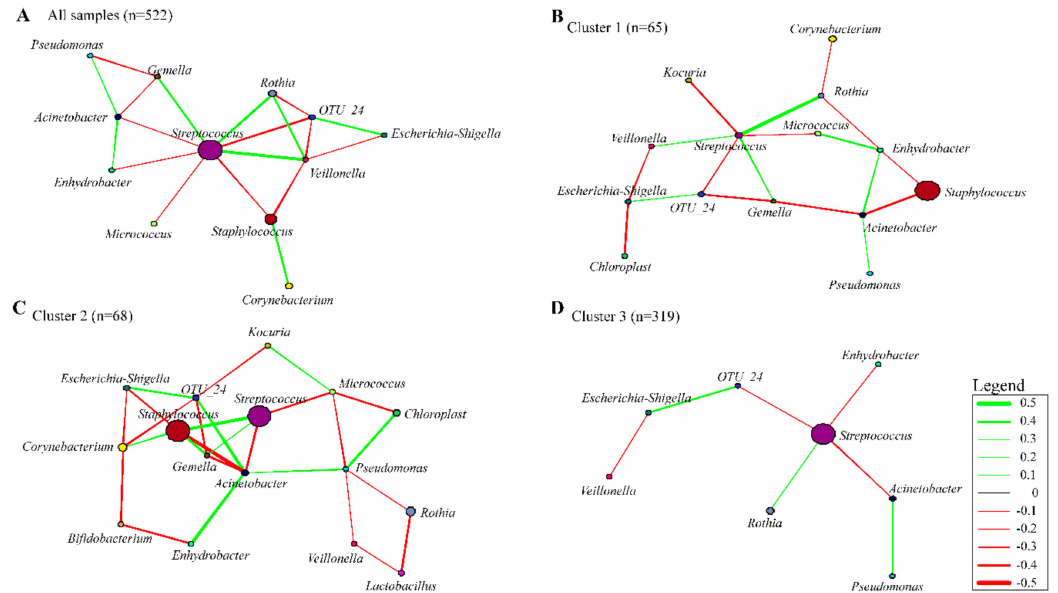
Figure 7. Bacterial networks within the human breast milk bacteriome community based on correlation between relative abundances. Figures show correlations between predominant bacteria in ( A ) all HBM samples, ( B ) cluster 1, ( C ) cluster 2, and ( D ) cluster 3. Nodes and node sizes represent bacterial genera and their relative abundances, respectively. Green and red lines represent positive and negative correlations respectively between the bacteria, with the thickness of the line indicating the degree of